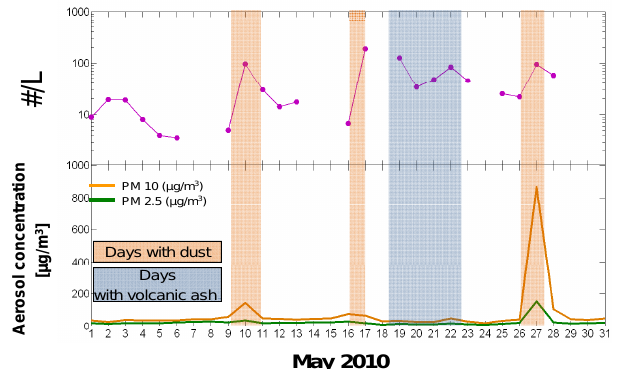
Fig. 5. Number concentration of ice nuclei (at − 18 ◦ C and water saturation) and concentration of particulate matter below 10µm di- ameter (PM 10 ) and below 2.5µm (PM 2 . 5 ) at Tel Aviv University during May 2010.